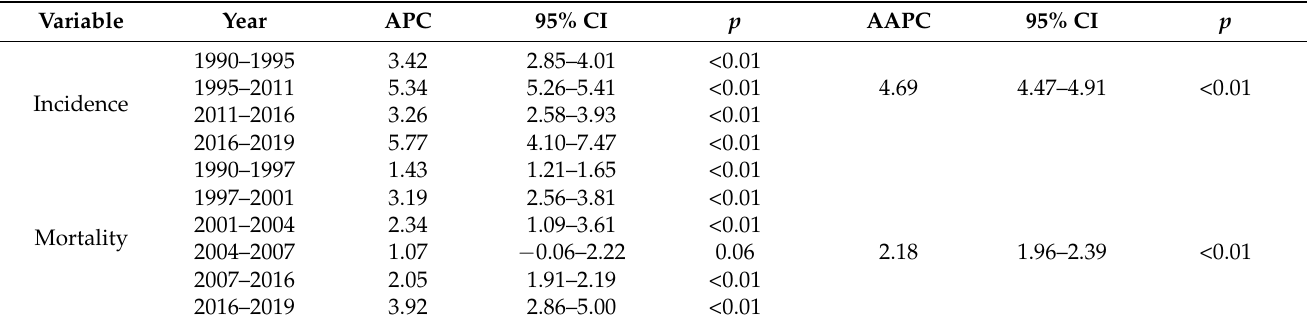
Table 1. Crude incidence and mortality trends of breast cancer in Chinese women from 1990 to